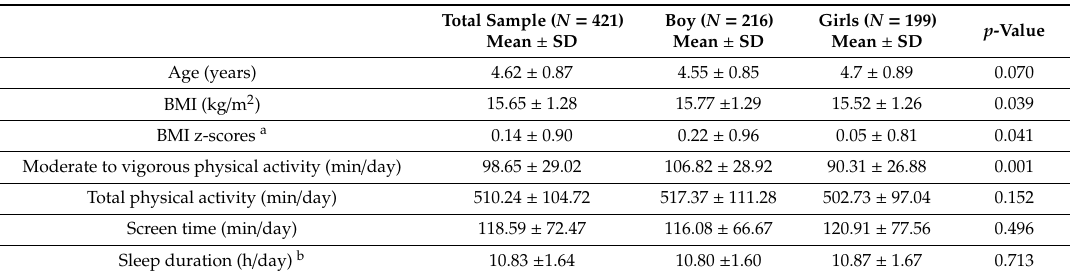
Table 1. Descriptive characteristics of